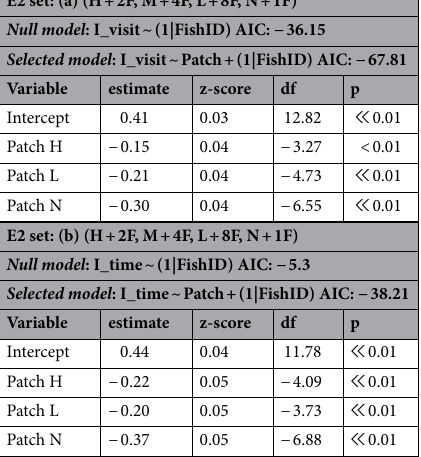
Table 3. Summary of results of generalized linear mixed models indicating effect of patch (female number + vegetation density) and fish id (random factor) on (a) proportion of visits (I_visit), (b) proportion of time spent (I_time), in E2 set.